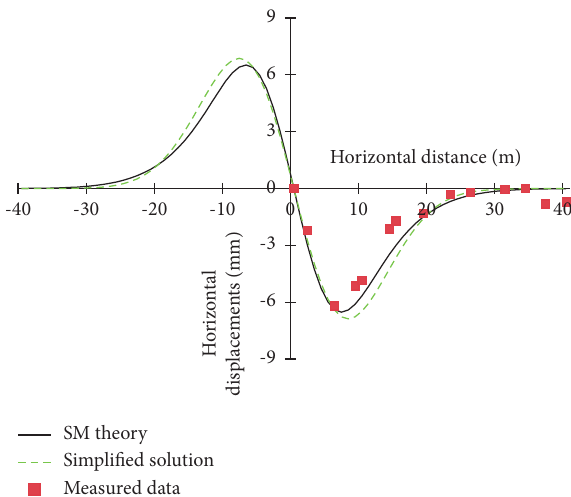
Figure 6: Measured and analytical ground horizontal displacement of Pushan Subway 1 st Line